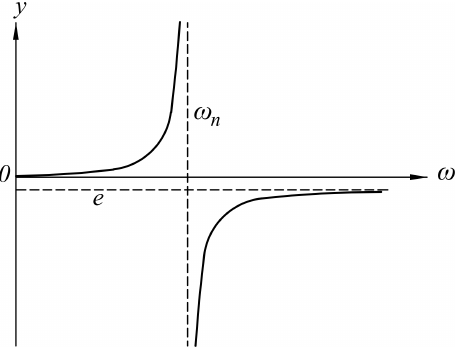
Figure 3. Graph of angular speed ω (rpm) versus shaft deflection y (mm).